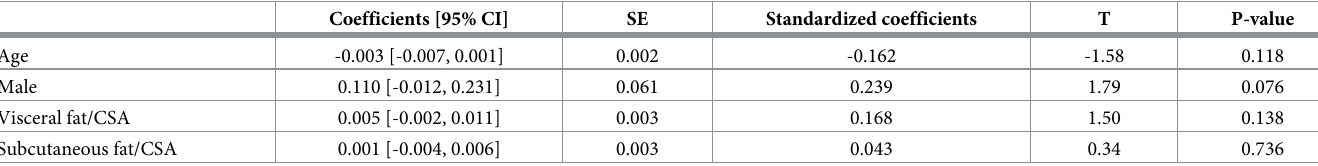
Table 9. Multiple regression analysis based on CT data (60 min after the surgical